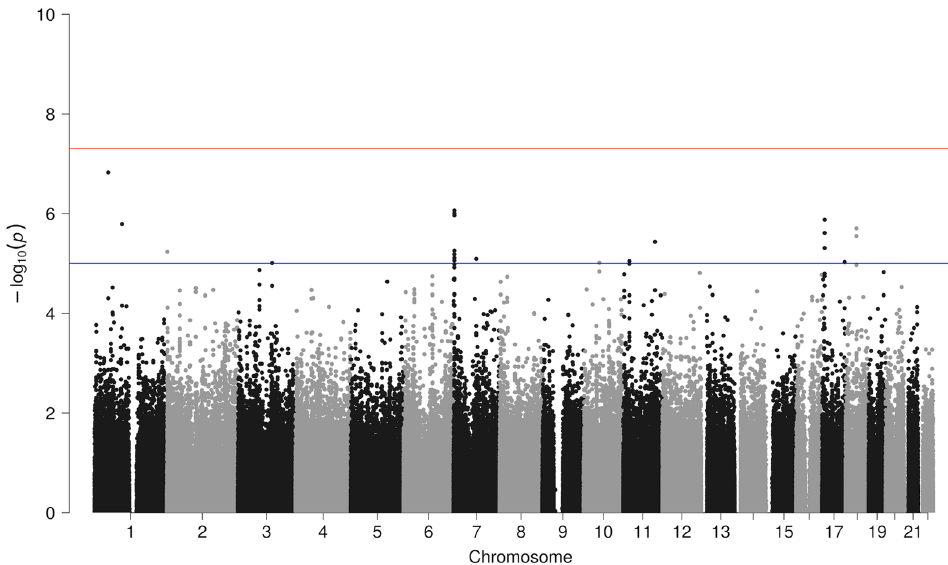
Figure 3. Manhattan plot of multi-trait GWAS results. The more significant the association, the higher the "skyscraper.” The red horizontal line represents the genome-wide significance threshold, while the blue line corresponds to the suggestive threshold.